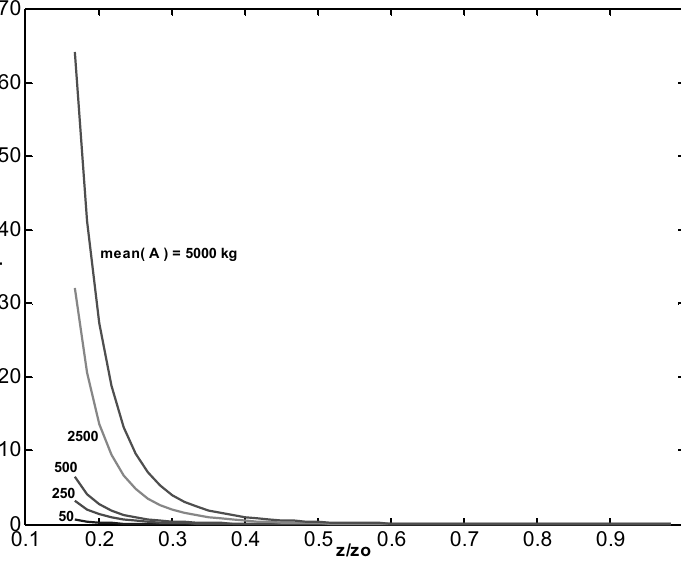
Fig. 8. Variation of the normalized oscillating shear stress (with respect to the static normal stress) with the normalized depth, for several values of the mean load magnitude.